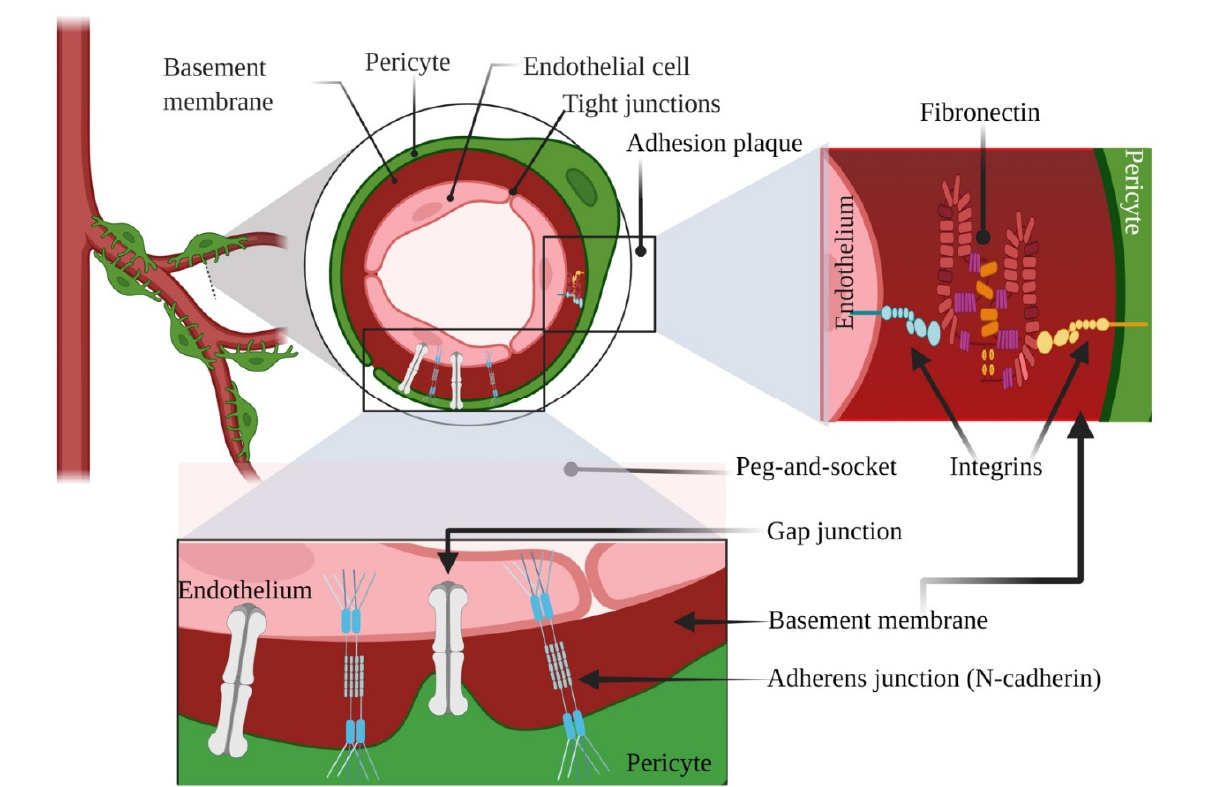
Figure 1. Illustrative representation showing typical pericyte-endothelial interconnections. Created with BioRender.com, Agreement number YY238VSLPL. Retrieved 26 November 2021 .